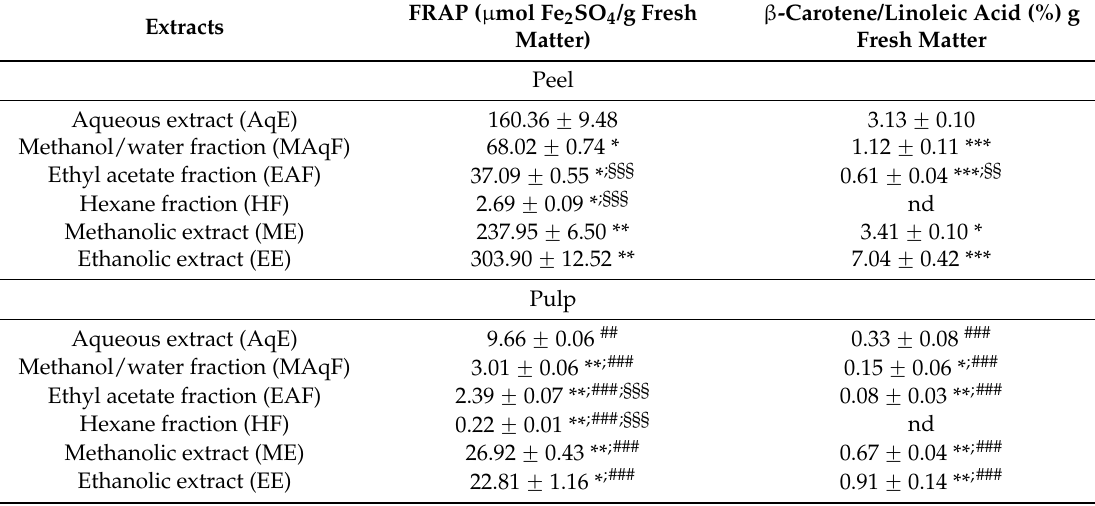
Table 2. Antioxidant activity of peel or pulp of tucum-do-cerrado extracts. FRAP ( µ mol Fe 2 SO 4 /g Fresh Extracts